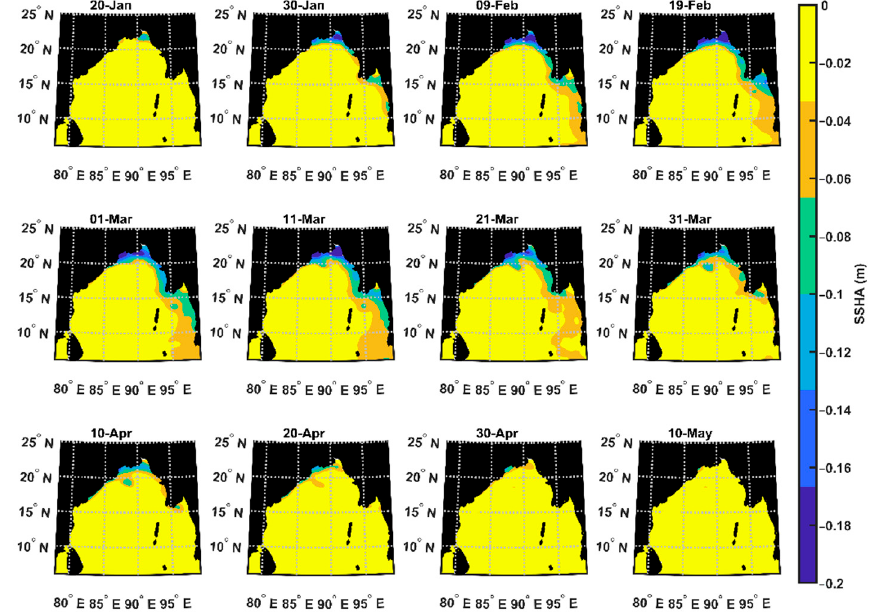
Figure 7. Decadal Climatology (2009 to 2018) of positive SSHA corresponding to the 1st upwelling Kelvin wave activity.